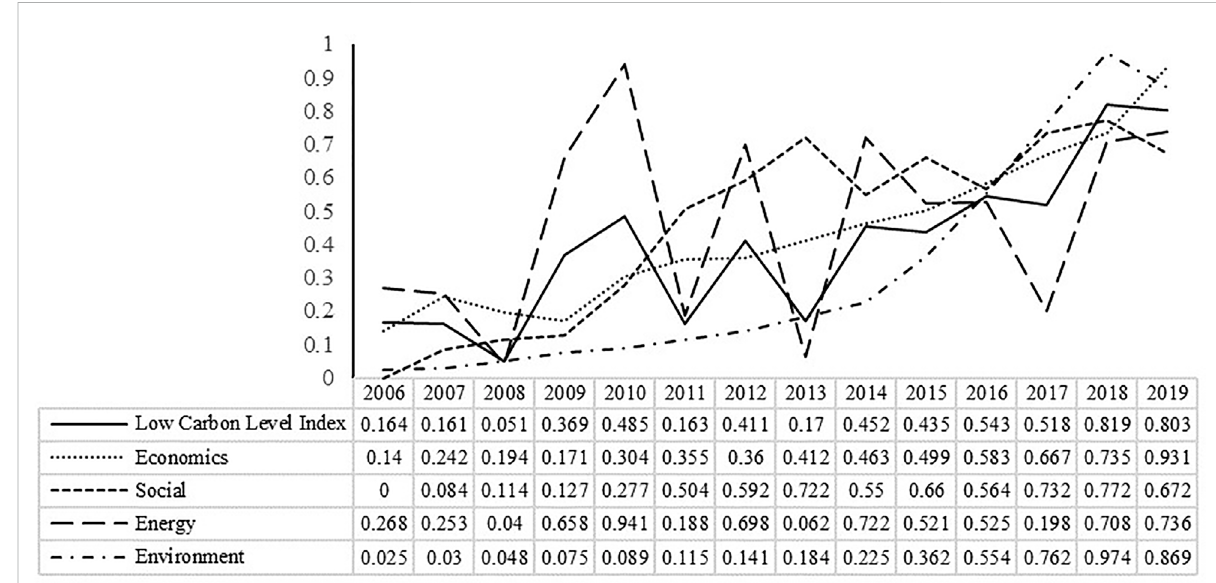
FIGURE 1 Low-carbon development level index and development level index of each subsystem of Fujian